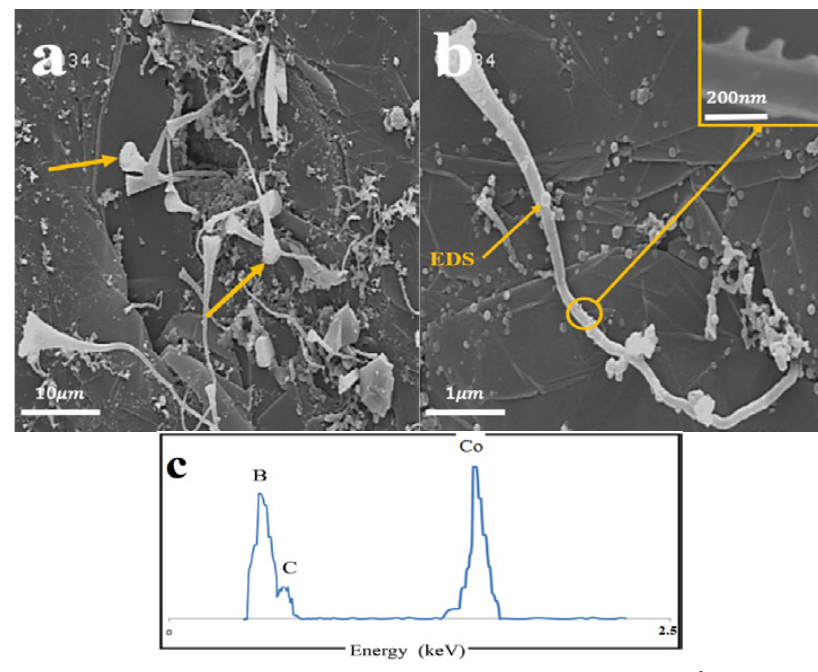
Fig. 9. the SEM image of the catalyst which has been applied to the crucible lid. (a) and (b) at 1500 ⁰C with various magnifications, (c) the EDS analysis result of the highlighted point. .